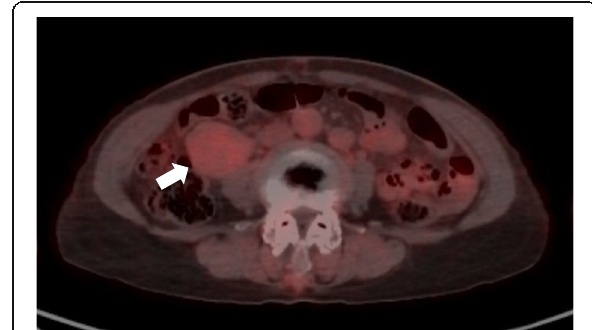
Fig. 3 18 F-fluorodeoxyglucose positron emission tomography (FDG- PET) of the leiomyosarcoma. Axial fusion images of FDG-PET revealing that the tumor (white arrows) had relatively low uptake